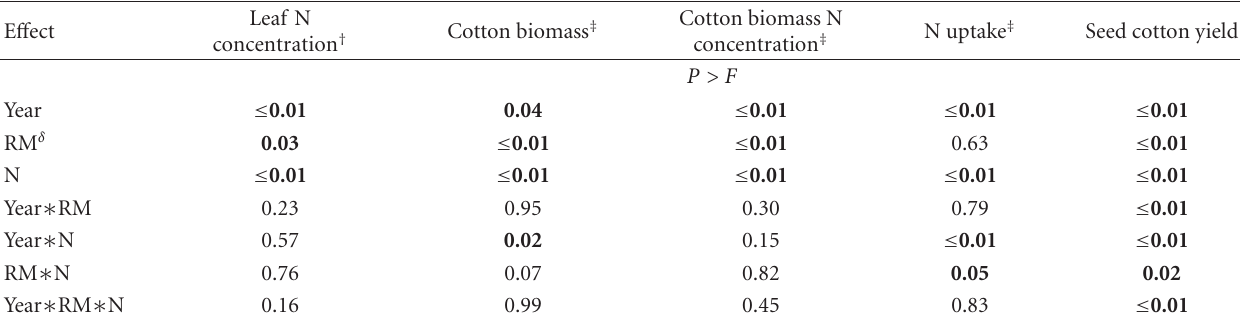
Table 2: Analysis of variance for the e ff ect of year, rye residue management, and N fertilization on leaf N concentration at early bloom, cotton biomass, cotton biomass N concentration and N uptake between first square and cutout, and seed cotton yield. P values within a row in bold are significant at α ≤ 0 . 05.